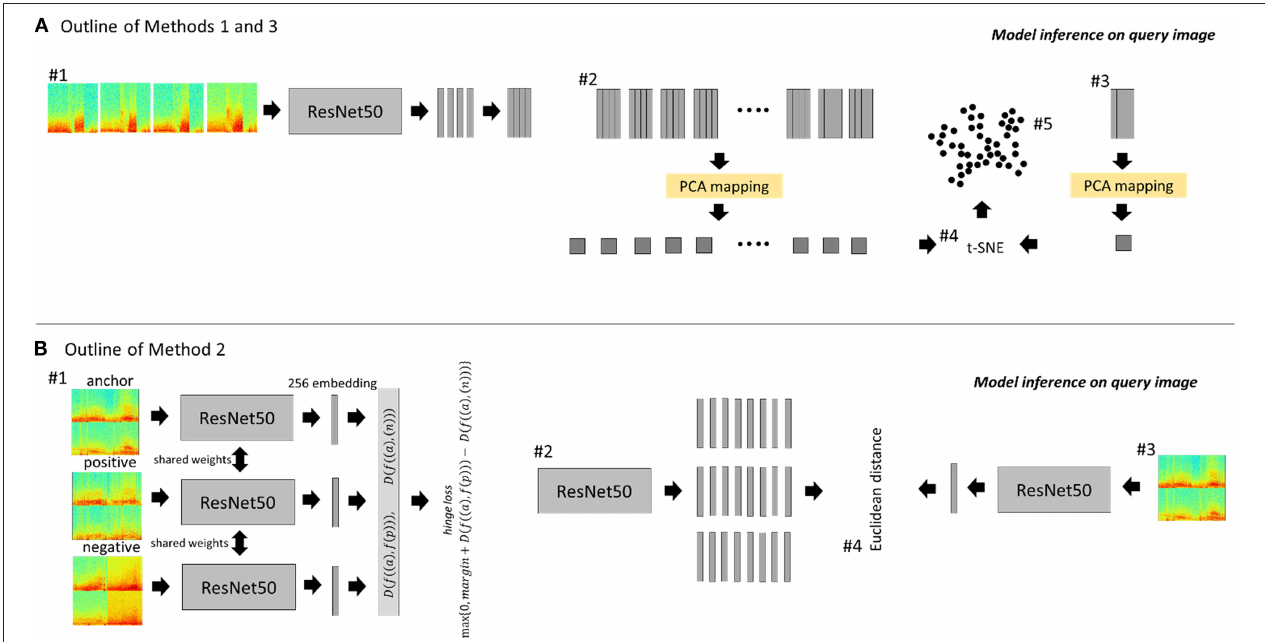
FIGURE 3 | Outline of methods for identifying similar cross-patient iEEG records. (A) ESC-ResNet and ImageNet-ResNet methods. #1: Each channel of a time-series iEEG record is converted to a 3-color channel spectrogram image. The spectrogram images are passed through a CNN feature extractor. #2: The resulting features from all search iEEG records are analyzed by PCA. The resulting PCA mapping function is saved. #3: At inference time, the feature map of the query image and its channel permutations are passed through the previously saved PCA mapping function. #4: The 50 principal components of all search images and the query image (and its channel permutations) are passed through t-SNE. #5: K-nearest neighbors is used to find the 5 iEEG records closest to the query image and its channel permutations. (B) CL-ResNet method. #1: Spectrogram images of 4-channel iEEG records are tiled to form a single 224 x 224 x 3 spectrogram image for each iEEG record. Triplets were used to train a deep ranking model using the hinge loss function to embed similar images closer than dissimilar images. #2: The embeddings of all search images are generated. #3: At inference time, the embeddings of the query iEEG record and its channel permutations are generated. #4: The five